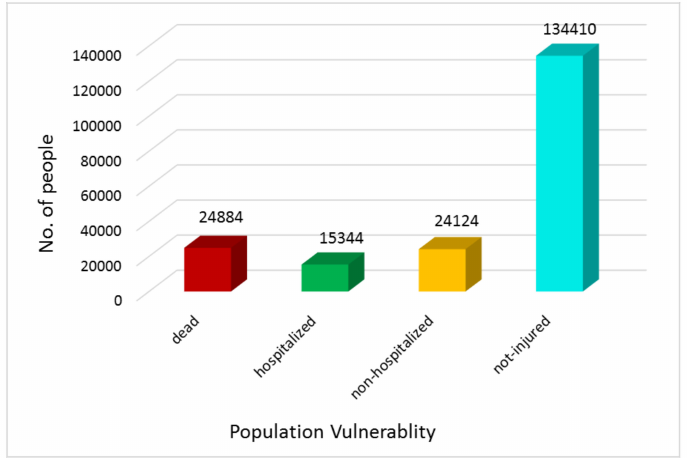
Figure 11. The estimated population